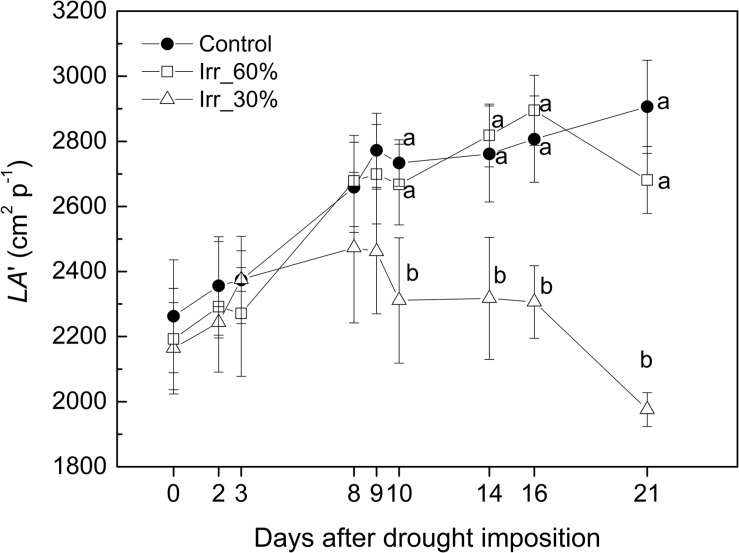
Evolution of the estimated leaf area (LA’) in grapevines under drought stress receiving 60% (□, IRR60%) and 30% (Δ, IRR30%) of the available water capacity and well watered (•, CTRL).